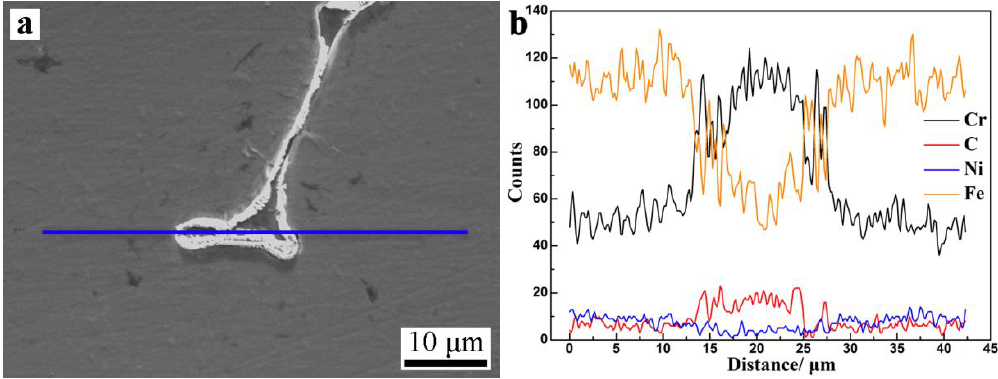
Figure 7. ( a ) SEM micrograph and ( b ) elemental line scanning images (Cr, C, Ni, and Fe) of interdendritic segregation in the ESR ingot. Blue line in ( a ) is the range of line scan.